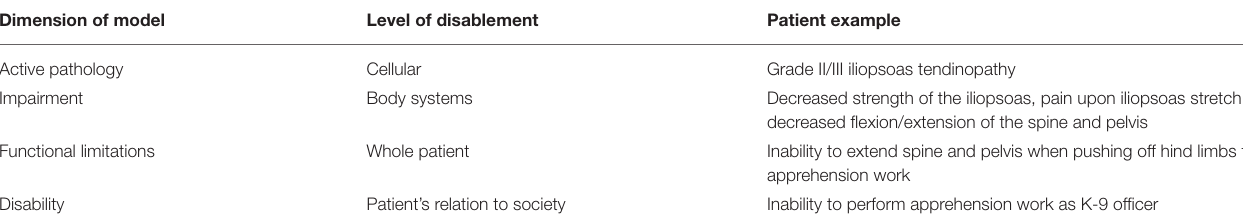
TABLE 3 | Nagi model applied to a law enforcement canine patient with a grade II/III iliopsoas tendinopathy. Dimension of